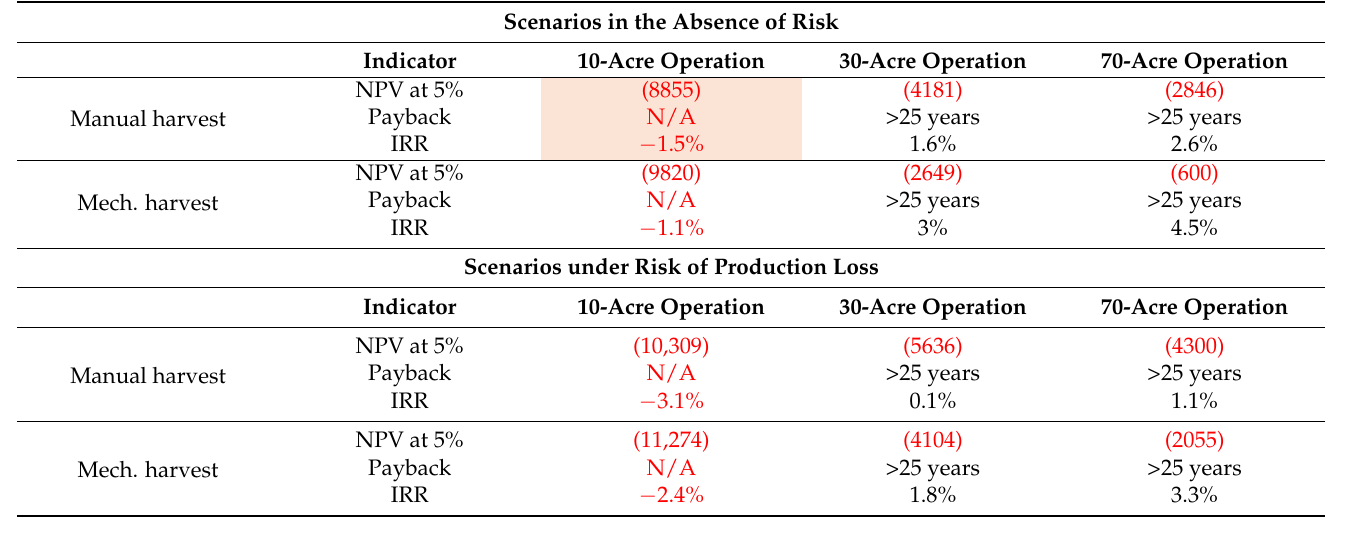
Table 9. Feasibility indicators of hybrid cultivar vineyards in 12